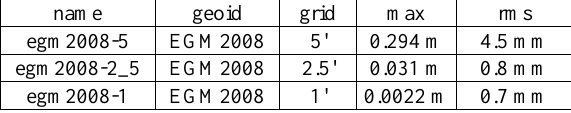
Table 3. Interpolation and quantization errors for geoid heights (https://geographiclib.sourceforge.io/)